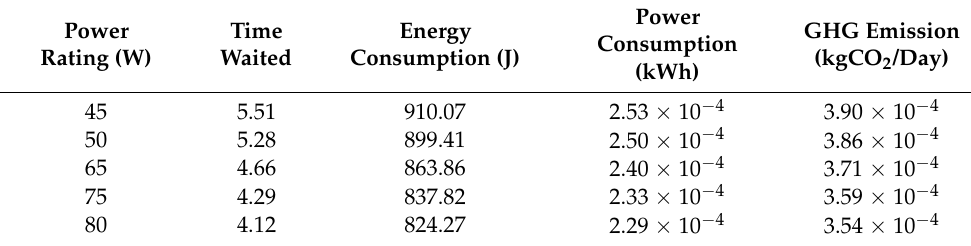
Table 2. GHG analysis for the dual tank with respect to energy consumption.